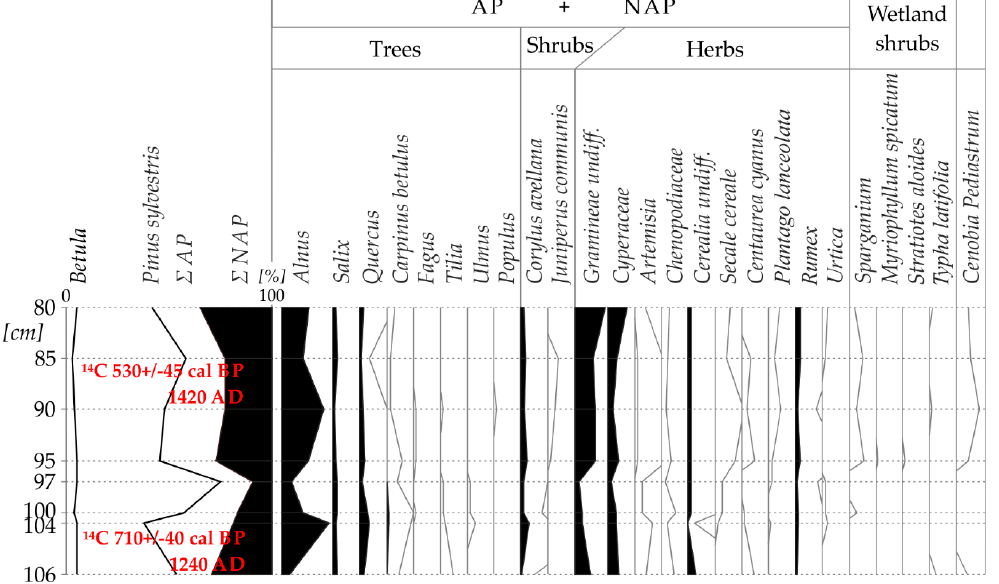
Figure 6. The Oleszek pollen diagram (selected plants).